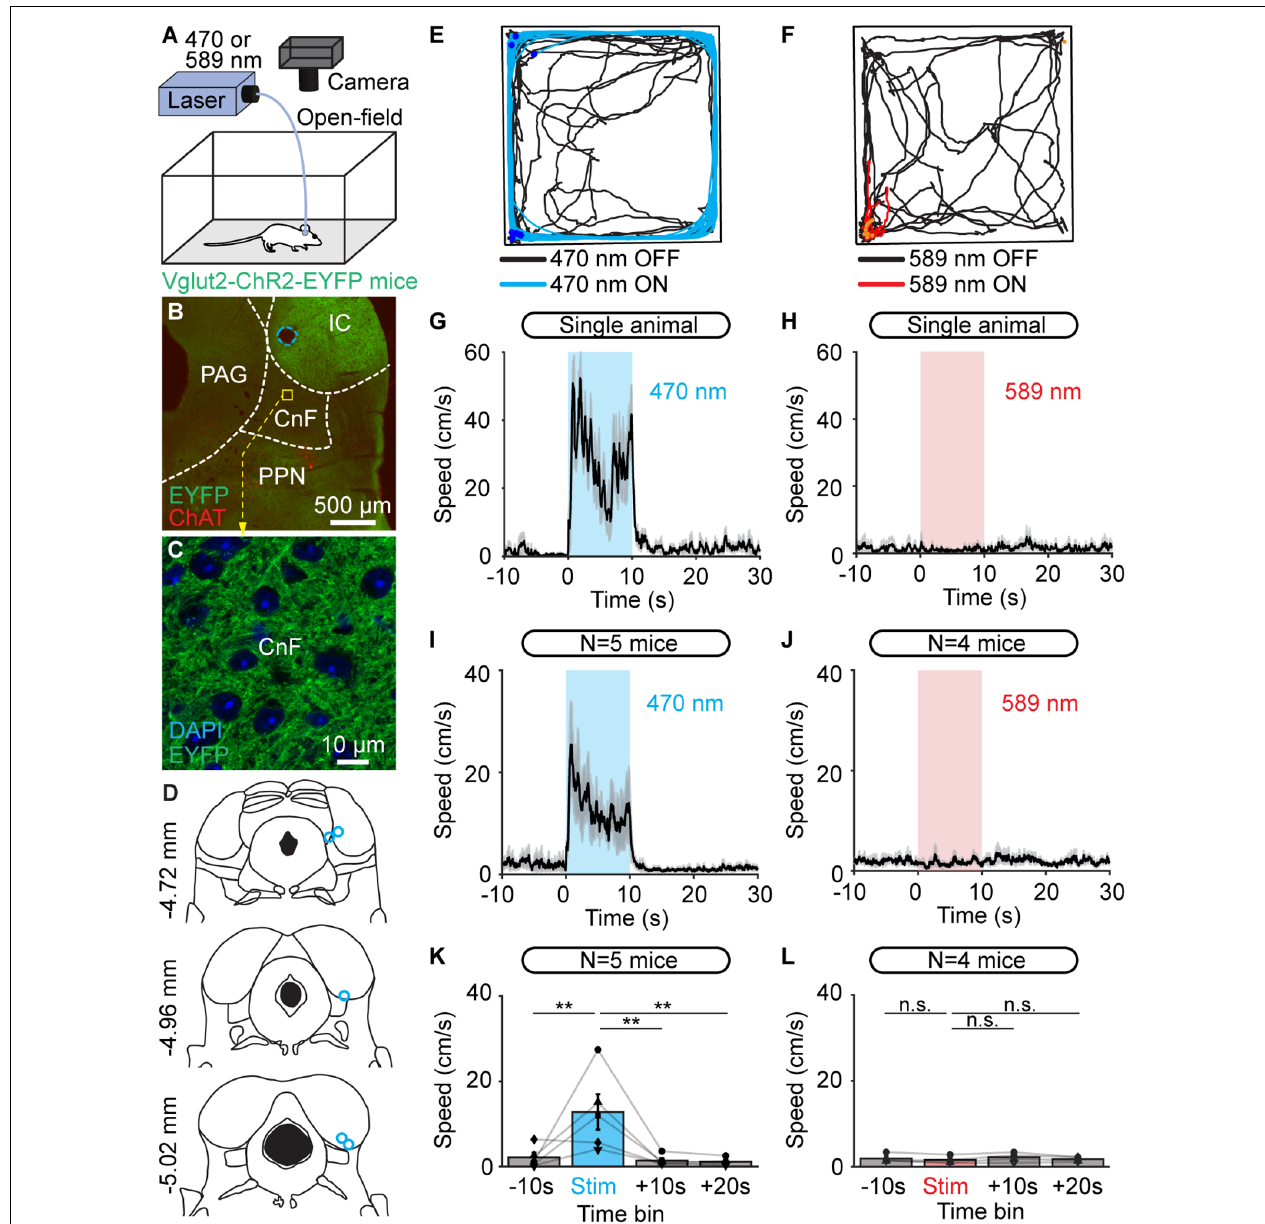
FIGURE 2 | Optogenetic stimulation of the cuneiform nucleus (CnF) increases locomotor speed in the open-field arena in Vglut2-ChR2-EYFP mice. (A) An optic fiber implanted in the right CnF was connected to a blue laser (470 nm) or red laser (589 nm). Animals were placed in an open-field arena (40 × 40 cm) and their movements were recorded using a camera placed above. (B) Photomicrograph showing the position of the optic fiber (dashed blue line) ∼ 500 µ m above the target site. The cholinergic neurons of the pedunculopontine nucleus (PPN; choline acetyltransferase positive, ChAT, red) and the expression of EYFP (green) are visible. (C) Magnification of the slice in (B) at the level of the CnF, showing the expression of ChR2-EYFP. (D) Location of the optic fibers (blue circles) after histological verification as illustrated in (B) , with the relative position to the bregma. (E,F) Raw data showing the effects of 10 optogenetic stimulations with a 470 nm laser ( E , light blue lines, 10 s train, 20 Hz, 10 ms pulses, 11% of laser power) or a 589 nm laser ( F , red lines, 10 s train, 20 Hz, 10 ms pulses, 53% of laser power). A time interval of 80 s was left between two trains of stimulation. Therefore, the time elapsed is different during stimulation (10 s, red or blue traces) and rest (80 s, black traces). The position of the animal’s body center was tracked frame by frame with DeepLabCut (see “Materials and Methods” section). Dark blue dots (E) and orange dots (F) illustrate the onset of each stimulation. (G,H) Locomotor speed (mean ± SEM) as a function of time before, during, and after a 10 s optogenetic stimulation (onset at t = 0 s) with a 470 nm laser (G) or 589 nm laser (H) in a single animal (same animal as in E,F ). (I,J) Locomotor speed (mean ± SEM) before during and after optogenetic stimulation with a 470 nm laser in five animals ( I , 10 stimulations per animal, 10–24% of laser power) and with the 589 nm laser in four animals ( J , 10 stimulations per animal, 40–53% of laser power). (K,L) Locomotor speed (mean ± SEM) before ( − 10 to 0 s), during (0 to + 10 s), and after optogenetic stimulation ( + 10 to + 20 s and + 20 to + 30 s) with the 470 nm laser in five animals (K) and with the 589 nm laser in four animals ( L ; 10 stimulations per animal, ** P < 0.01, n.s.: not significant, P > 0.05, Student-Newman-Keuls test after a one way ANOVA for repeated measures, P < 0.01 in K and P > 0.05 in L